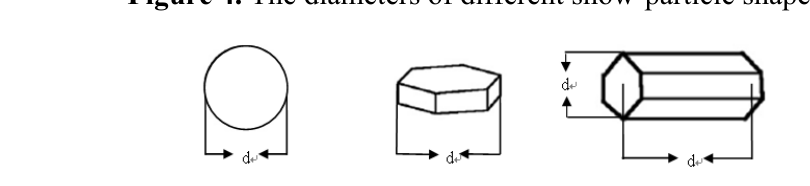
Figure 4. The diameters of different snow-particle